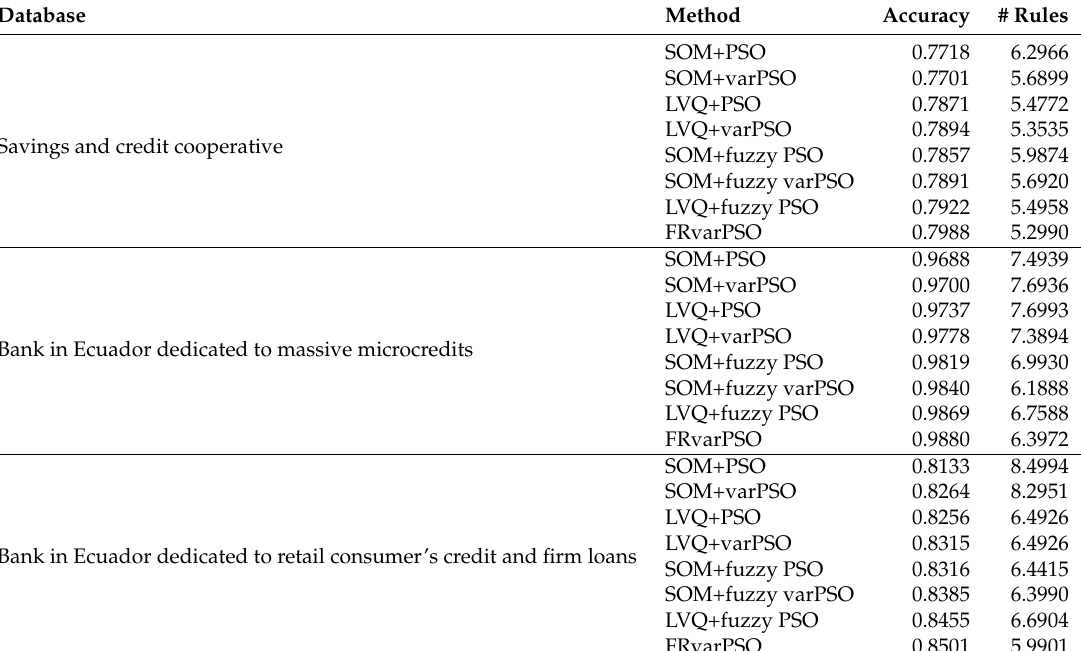
Table 1. Comparison of the accuracy and number of rules of hybrid and fuzzy models considered in this